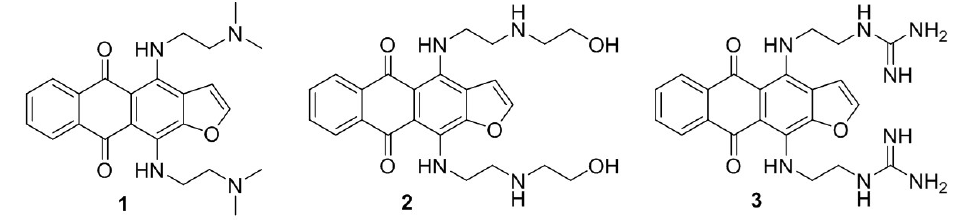
Figure 1. Structure of 4,11-diaminoanthra[2,3- b ]furan-5,10-dione derivatives 1 – 3 .